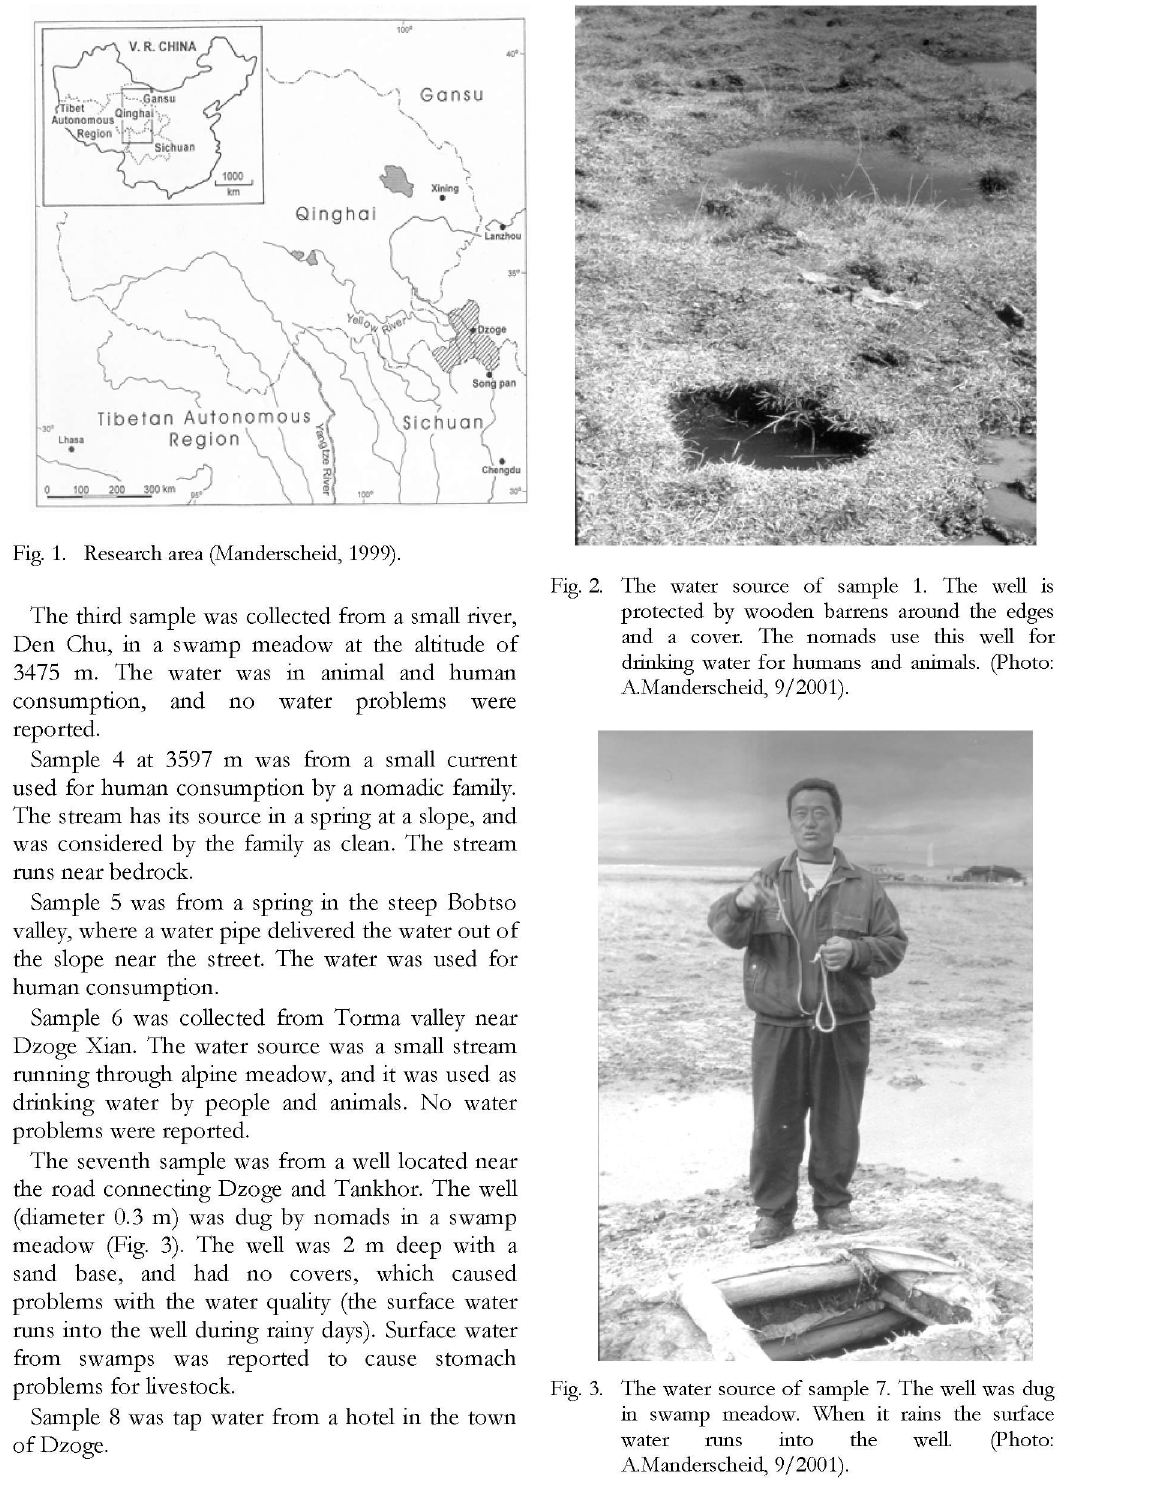
Fig. 3. The water source of sample 7. The well was dug in swamp meadow. When it rains the surface water runs into the well. (Photo: A.Manderscheid,